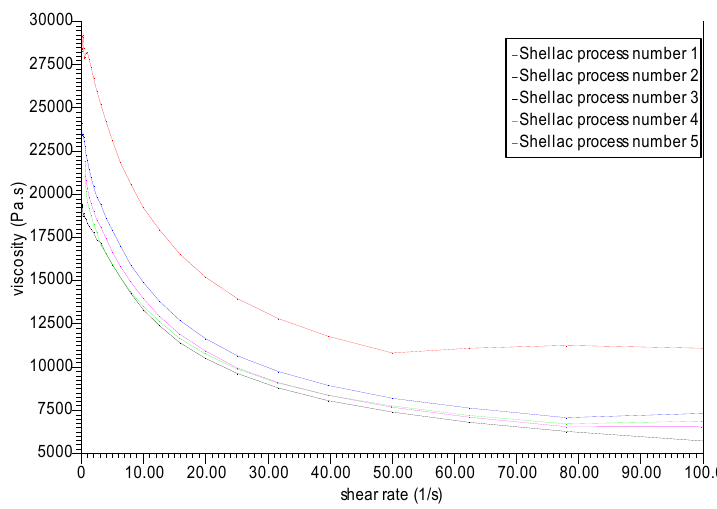
Figure 6. Viscosity ( η ) versus shear rate (1/s) for each process run.